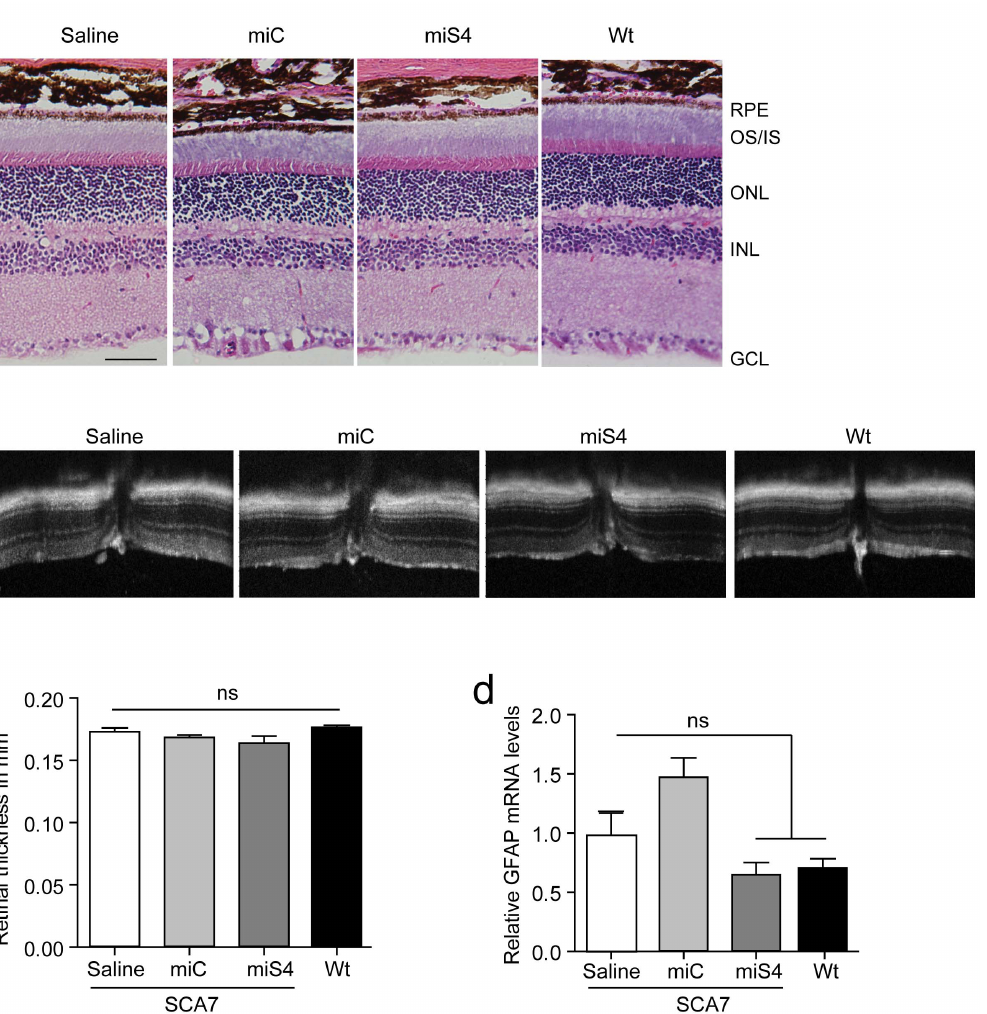
Figure 3. Assessing toxicity post-injection at 30 weeks. (a) Hematoxylin and eosin staining of retinas at 30 weeks (n=3 per group) (b) Optical coherence tomography (OCT) images of the retinas at the region of the optic nerve (n $ 6 per group). (c) Retinal thickness measured using the OCT images. (d) Relative GFAP mRNA levels in the injected retinas by RT-qPCR analysis. For (c; n $ 6 per group) and (d; n=3 per group), results are represented as mean 6 SEM.